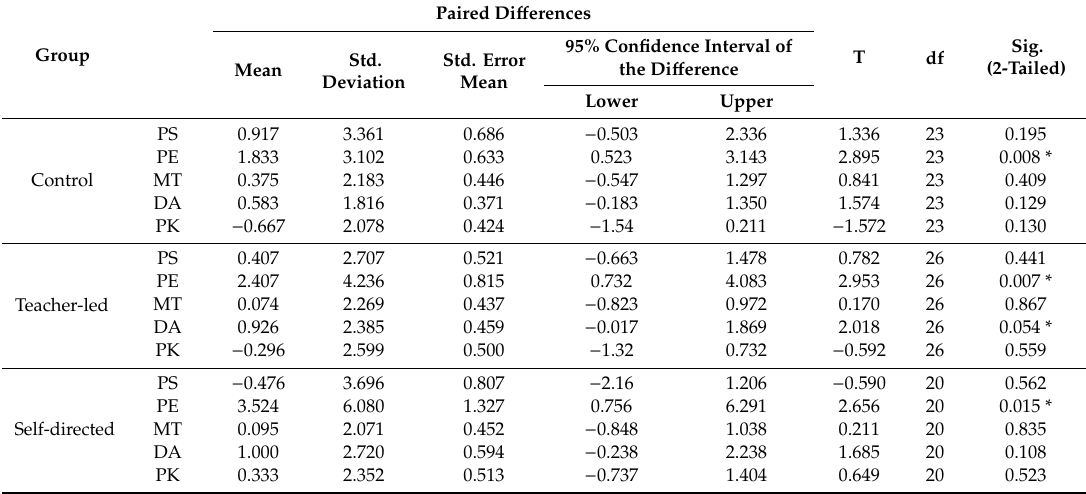
Table 4. Tests of within-subject e ff ects on metacognitive awareness